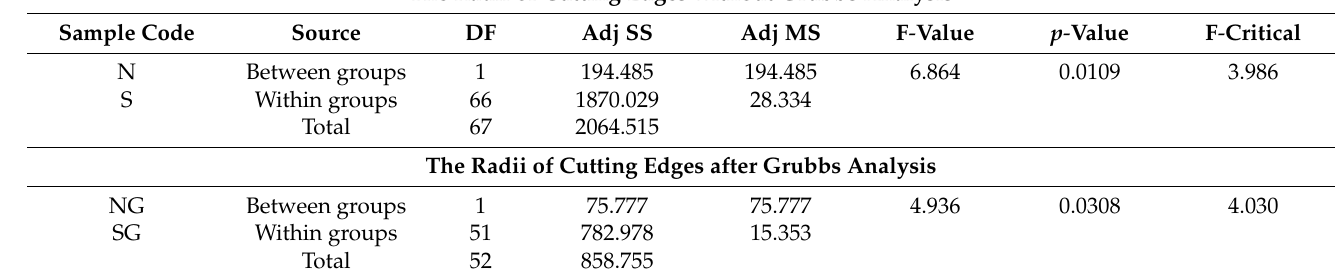
Table 1. Significance of differences of the cutting edge radii between a brand new and regenerated cutting saw blades (ANOVA) ( α =